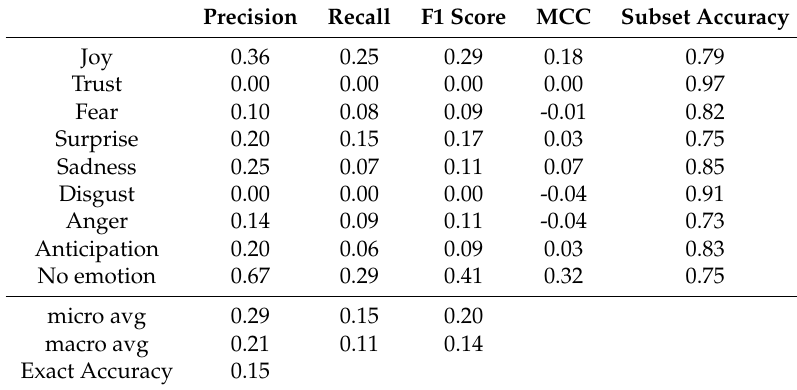
Table 5. Accuracy of Bag-of-Words representation, Multi-nomial Naive Bayes classifier. Precision Recall F1 Score MCC Subset Accuracy